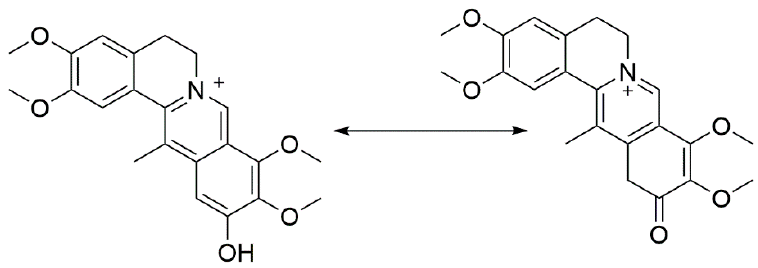
Figure 8. The arrangement of 11-hydroxyl dehydrocorydaline (DHC).